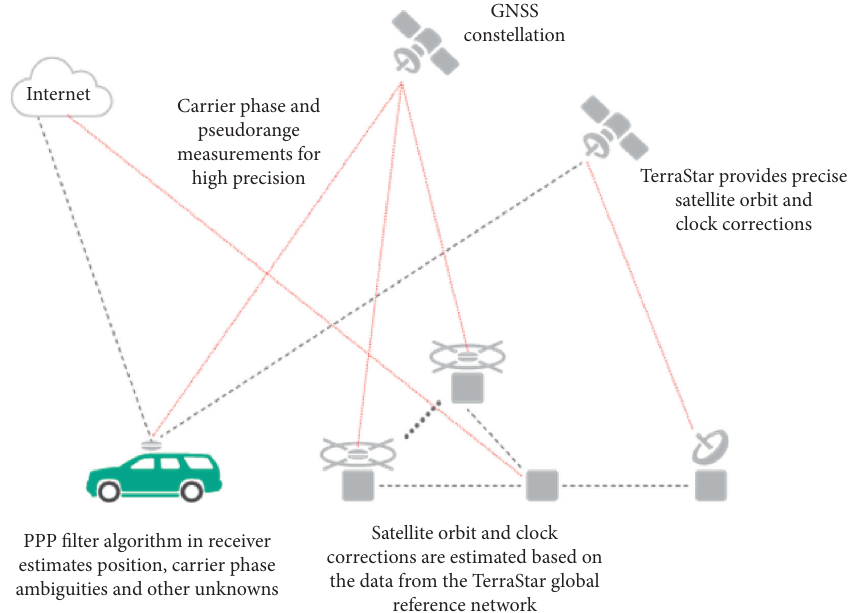
Figure 4: PPP (precise point positioning) technique to improve the accuracy of GNSS positioning using the Internet [75].